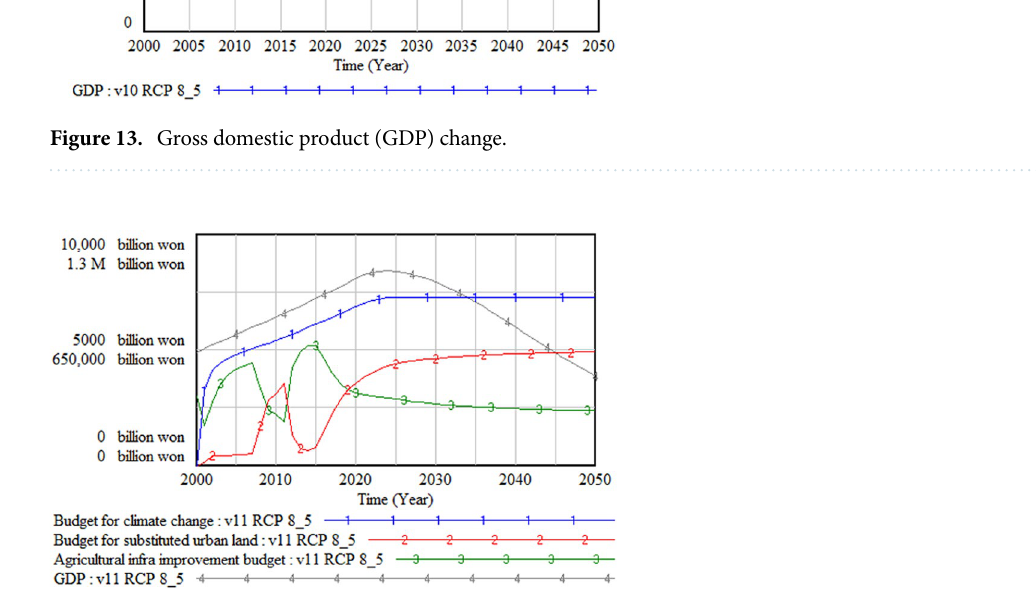
Figure 14. Climate change budget and its use. GDP = gross domestic